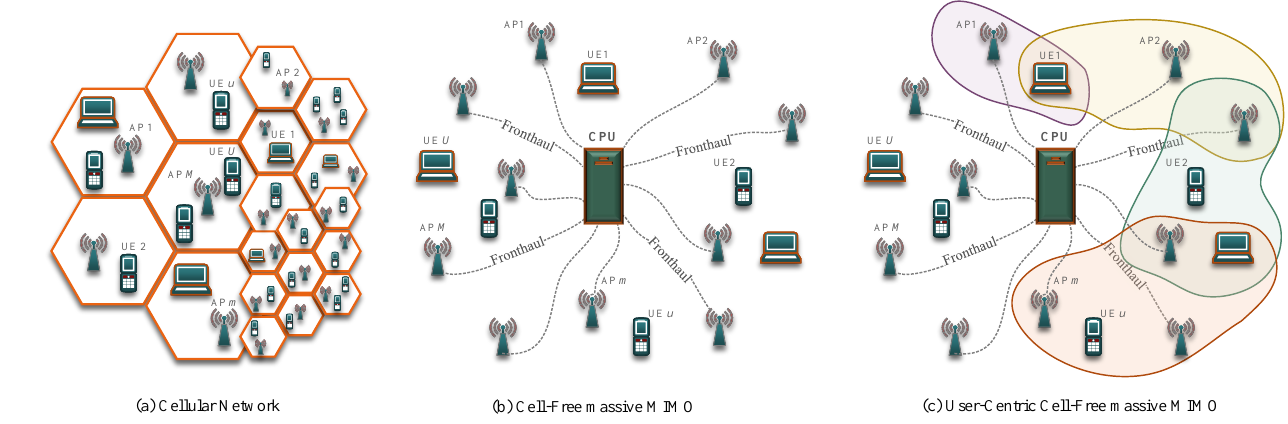
Figure 1. Cellular Network Architecture vs Cell-Free and User-Centric CF massive MIMO.